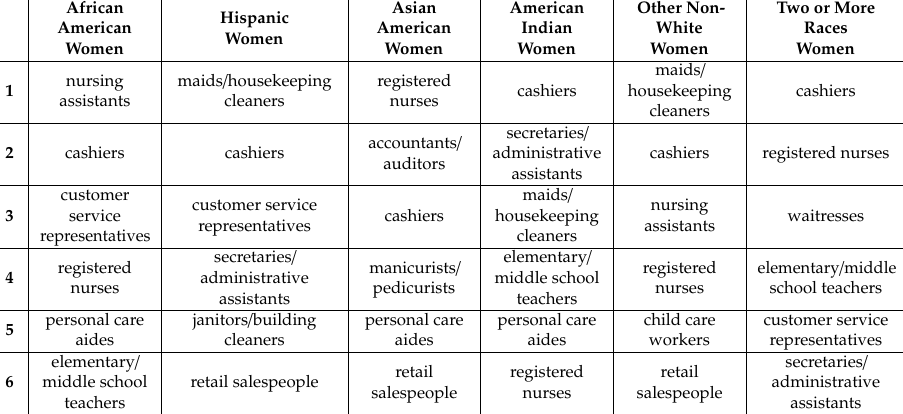
Table 1. Top six occupations held by women of color in the United States